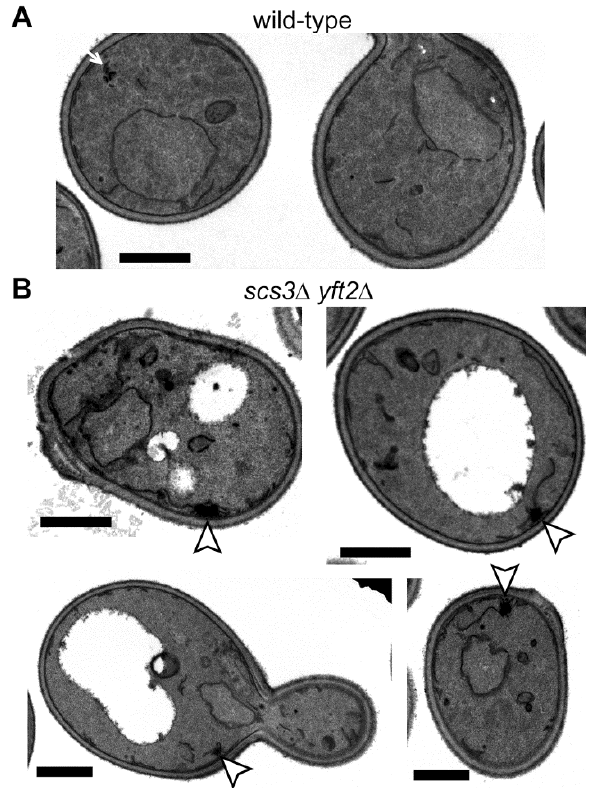
FIGURE 3: Ultrastructure of double delete scs3 ∆ yft2 ∆ cells